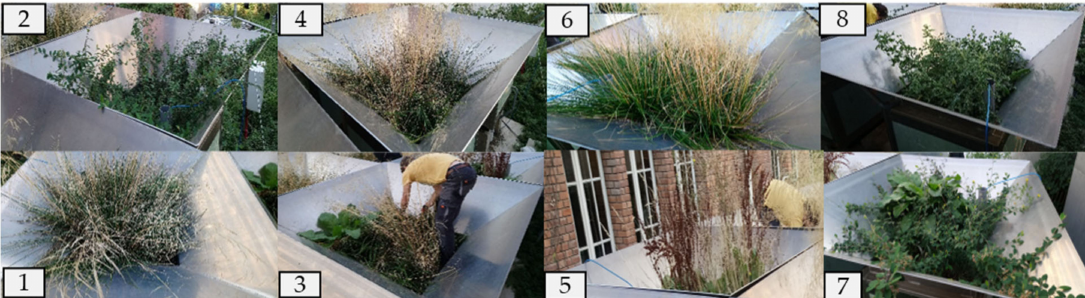
Figure A2. The vegetation in the eight lysimeters on 20 September 2018 (Source: DPE-STEA, Paris council). It can be observed particularly a development of the shrubs (lysimeter 2 and 7) and a revegetation of lysimeter 8 three months after all the plants have been removed.